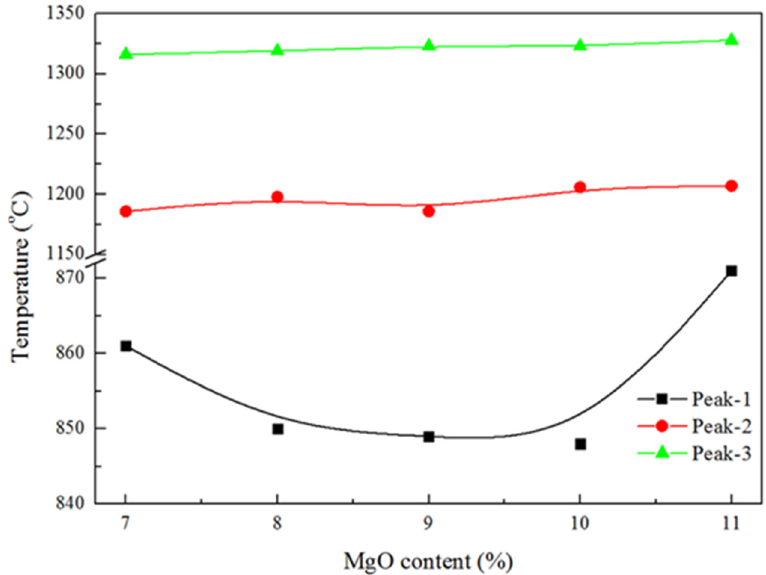
Figure 3. Local magnification of DSC curves of the BF slag in the temperature range of endothermic peak-1, exothermic peak-2, and peak-3.